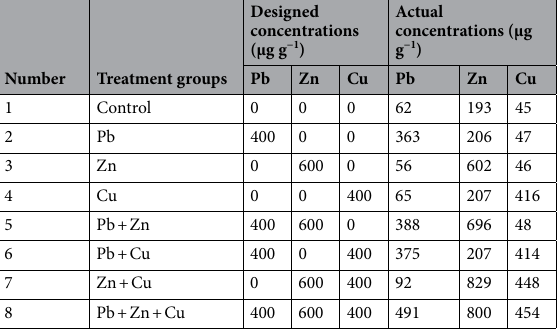
Table 4. Mixture matrix design of the mixture of Pb, Zn, and Cu in the this study.